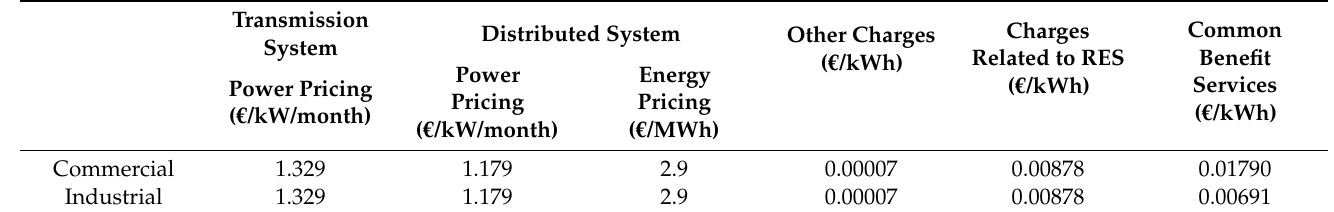
Table 11. BY regulated charges invoice of the Public Power Corporation (PPC) in Greece (www.dei.gr, last accessed at 5 January